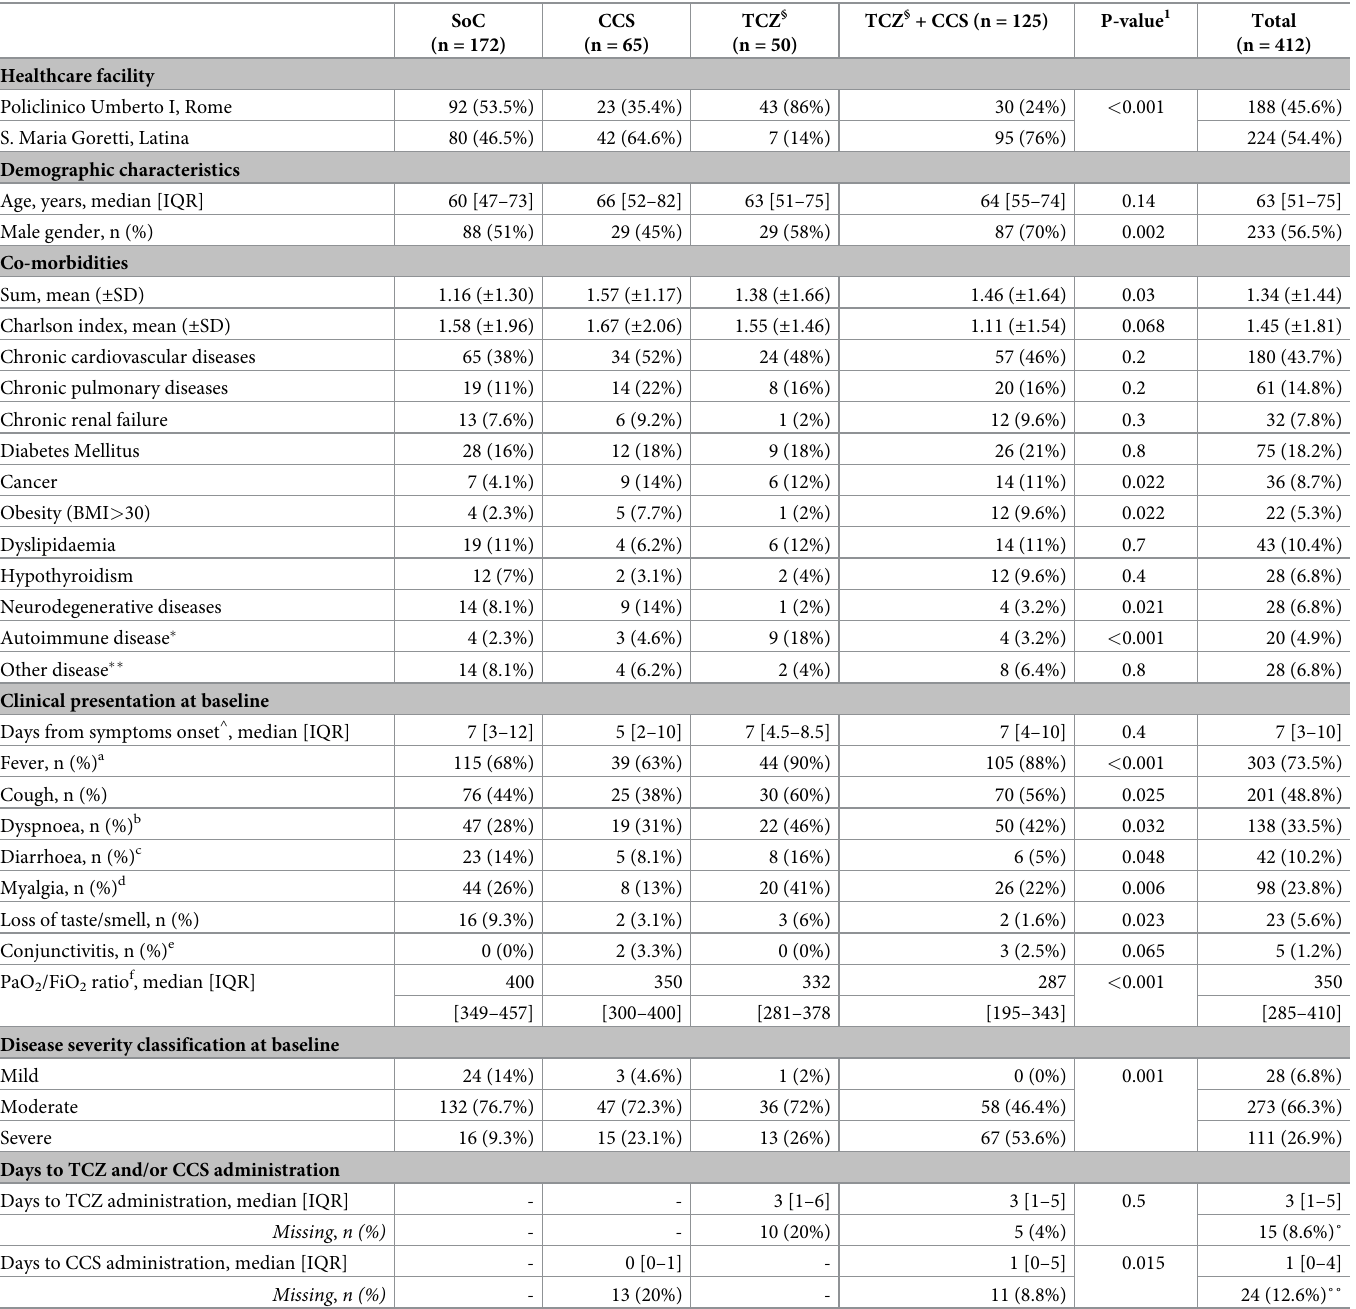
Table 1. Baseline characteristics of participants by treatment